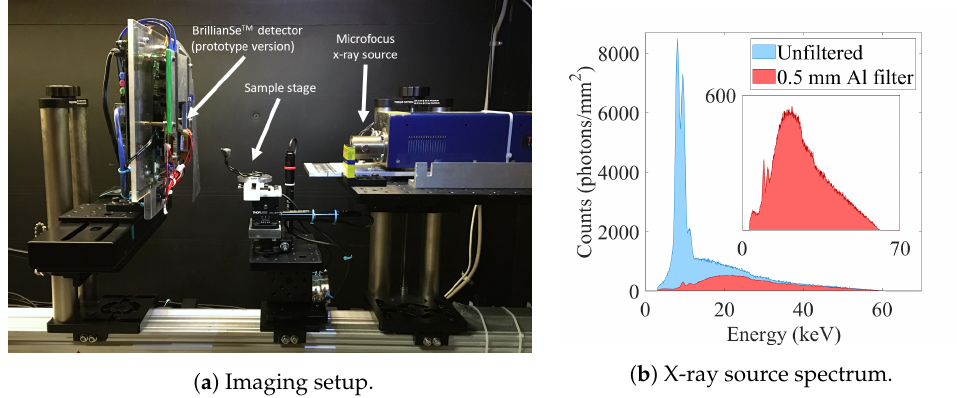
( a ) Imaging setup. ( b ) X-ray source spectrum. Figure 15. ( a ) The experimental setup used for PB-XPCi imaging with the tungsten target Thermo Scientific™ PXS5-927 Microfocus X-ray Source, sample stage, and a prototype version of the Bril- lianSe™ X-ray detector; ( b ) the spectrum of the source used for imaging—both the unfiltered and 0.5 mm Al filtered